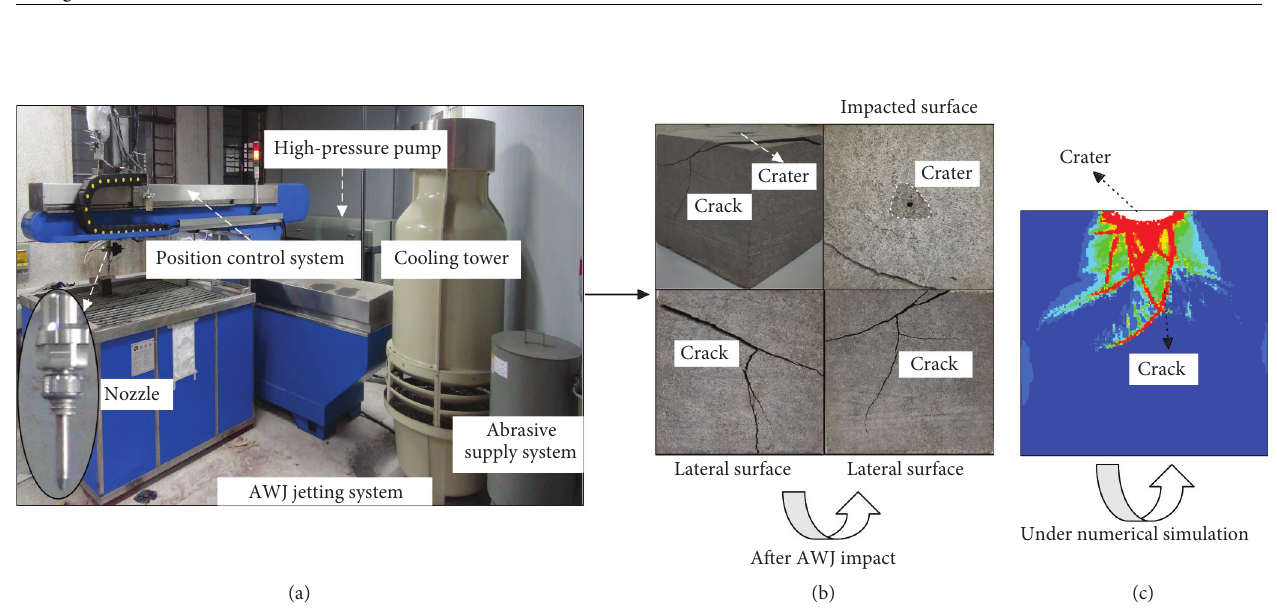
Figure 2: Experimental devices of AWJ impacting rock and the results.